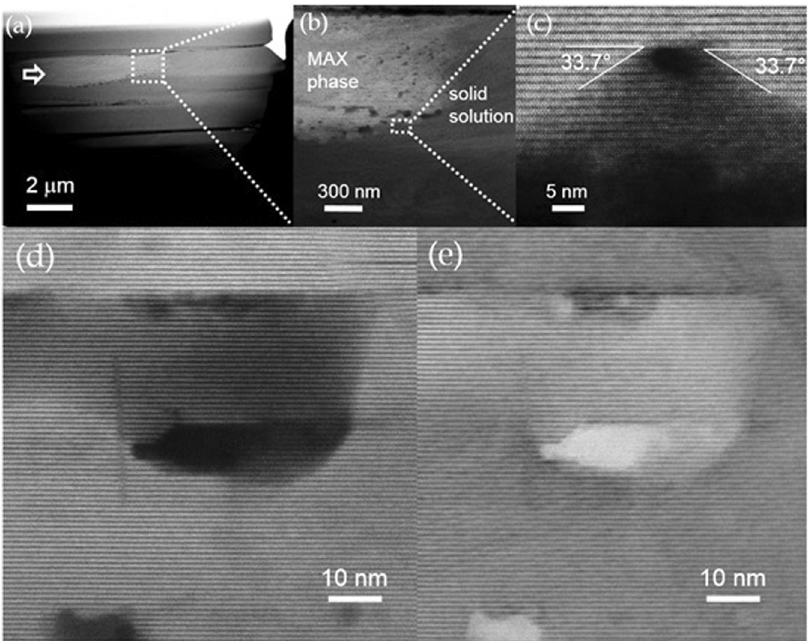
Figure 2. STEM-HAADF investigation. ( a ) Image of the Cr 2 AlC lamella exhibiting a columnar morphology. For all images in Fig. 2, the growth direction is from the left to the right. The dashed square indicates the region enlarged in ( b ). ( b ) Enlarged image of the location near the boundary of MAX phase area (brighter left part) with an increased defect density. ( c ) One defect is depicted as an example. Defects populate the boundary region between MAX phase and disordered solid solution. Simultaneously recorded dark-field and bright-field STEM images are shown in ( d ) and ( e ), respectively. The defects shown as black area in dark-field images appear to be white in the bright-field image. No sign of lattice fringes can be found in the defect, as a signature of filling with light elements or vacuum.